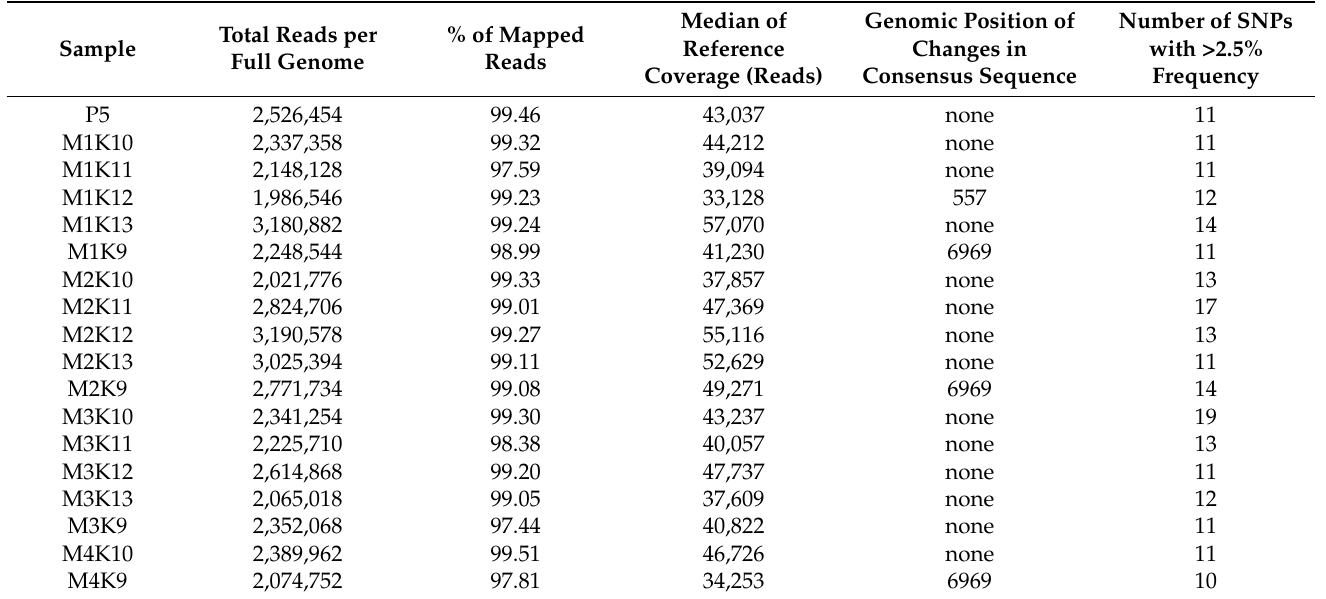
Table 4. Sequencing summary statistics in samples from the pooled 5th (P5) and individual 6th passage (MxKx) SMB